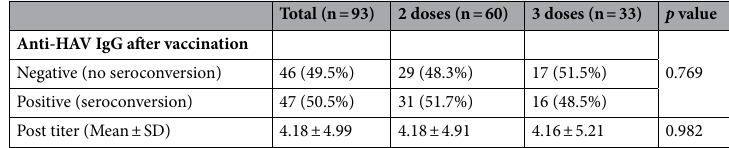
Table 3. Comparison of the vaccine response between 2- and 3-dose